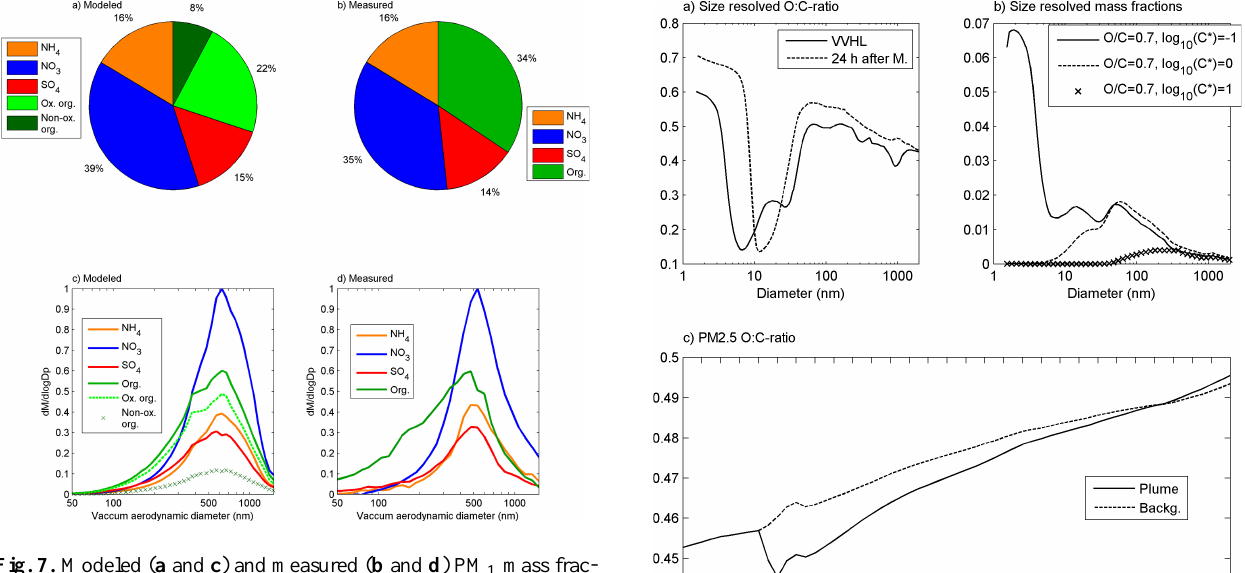
Fig. 7. Modeled ( a and c ) and measured ( b and d ) PM 1 mass frac- tions and mass size distributions of the compounds that can be de- tected with ToF-AMS. The mass size distributions were normalized with the maximum of the nitrate distributions. The chloride content was very low for the modeled and measured values and is therefore not shown. The model data is the average of the 26 model cases dur- ing 2005/2006, while the AMS data averages are from the Vavihill October and March campaigns during 2008/2009. The modeled or- ganic mass is divided into total organics (Org.), non-oxidized (O:C- ratio equal to zero) and oxidized material. In the model the only source for the non-oxidized organic material is low volatile POA emissions.